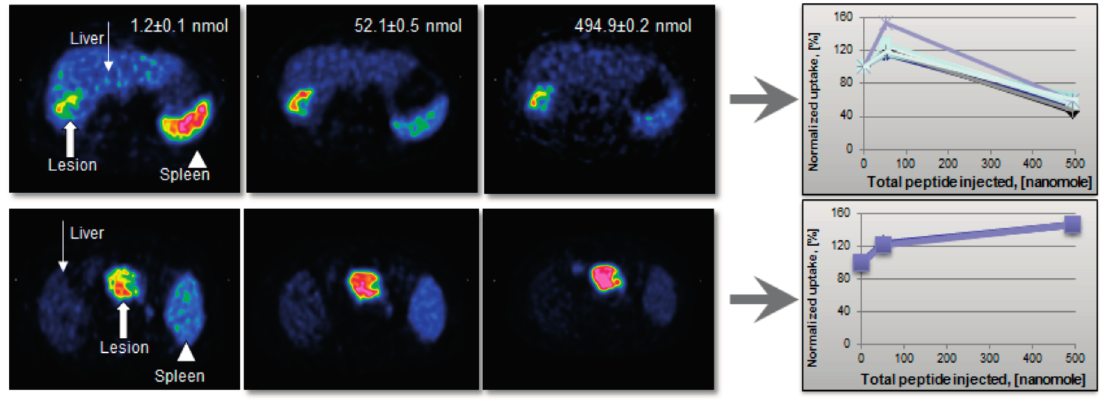
Figure 16. ( Upper panel ) Transaxial [ 68 Ga]-DOTA-TOC-PET images of a patient with